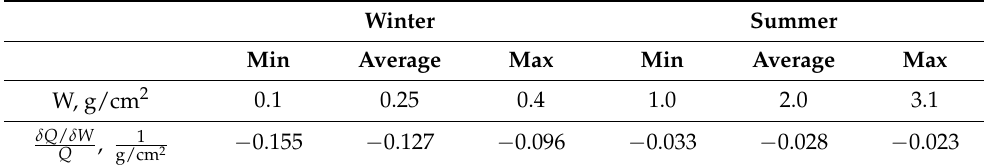
Table 2. Relative change of the flux Q due to the change in W .